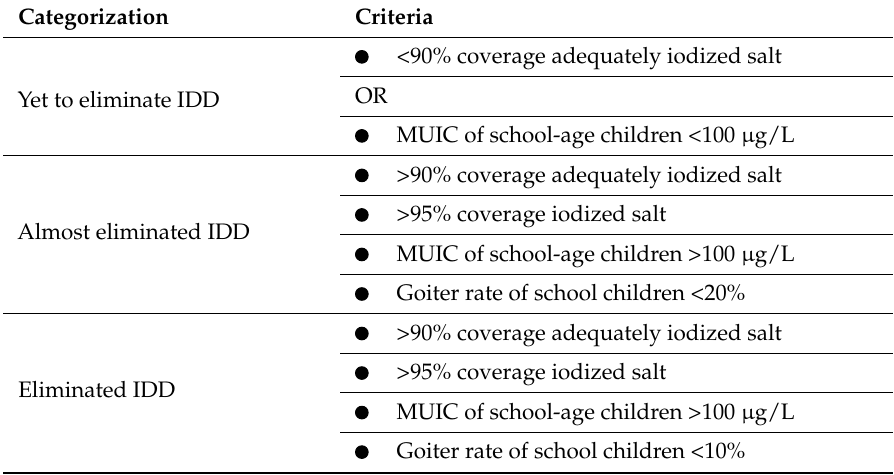
Table 2. Criteria for elimination of